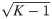
Impact of the number of rate categories and choice of estimation procedure on estimates of CV.For each of 13 mtDNA genes for 56 metazoan orders (721 total alignments, left plots), and for 1, 000 nuclear gene alignments (right plots) from the Selectome database, the estimated coefficients of variation (CV) for nonsynonymous rates (vertical axis) and synonymous rates (horizontal axis) are plotted for an increasing number of rate categories, K = 3, 4, 5, 7, 10. The plots in the left half of the figure show estimates obtained using the standard discrete gamma approach, while those in the right half were found using the GDD. The solid lines in each subplot mark the maximum possible CV estimate for the discrete gamma approach, K-1. Observe that as the number of rate categories increases, fewer estimates reach the upper bound for the discrete gamma; estimates for the GDD have no such constraint, regardless of the number of rate categories. Please note that the axes do not use a linear scale.